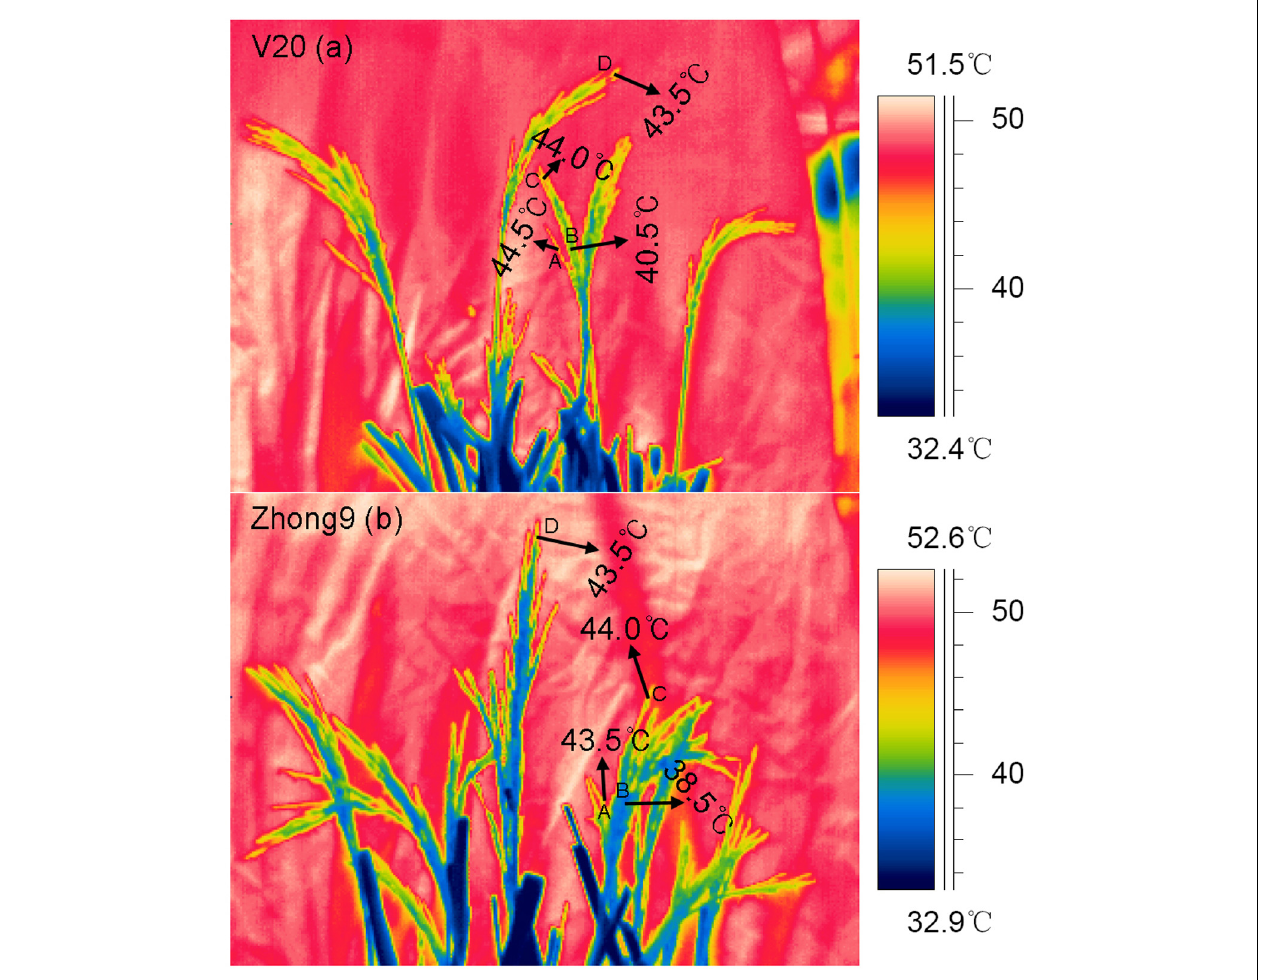
FIGURE 5 | Thermal images of spikelets on the branches in different located position within a panicle without leaves. These thermal images were photographed on day 4 after heat stress of 43 ◦ C at 10:00 am–11:00 am in another green house under the natural sunlight. In both genotypes, location A, and B were under the same canopy height, while B, C, and D located in different canopy height. (a) V20 and (b)